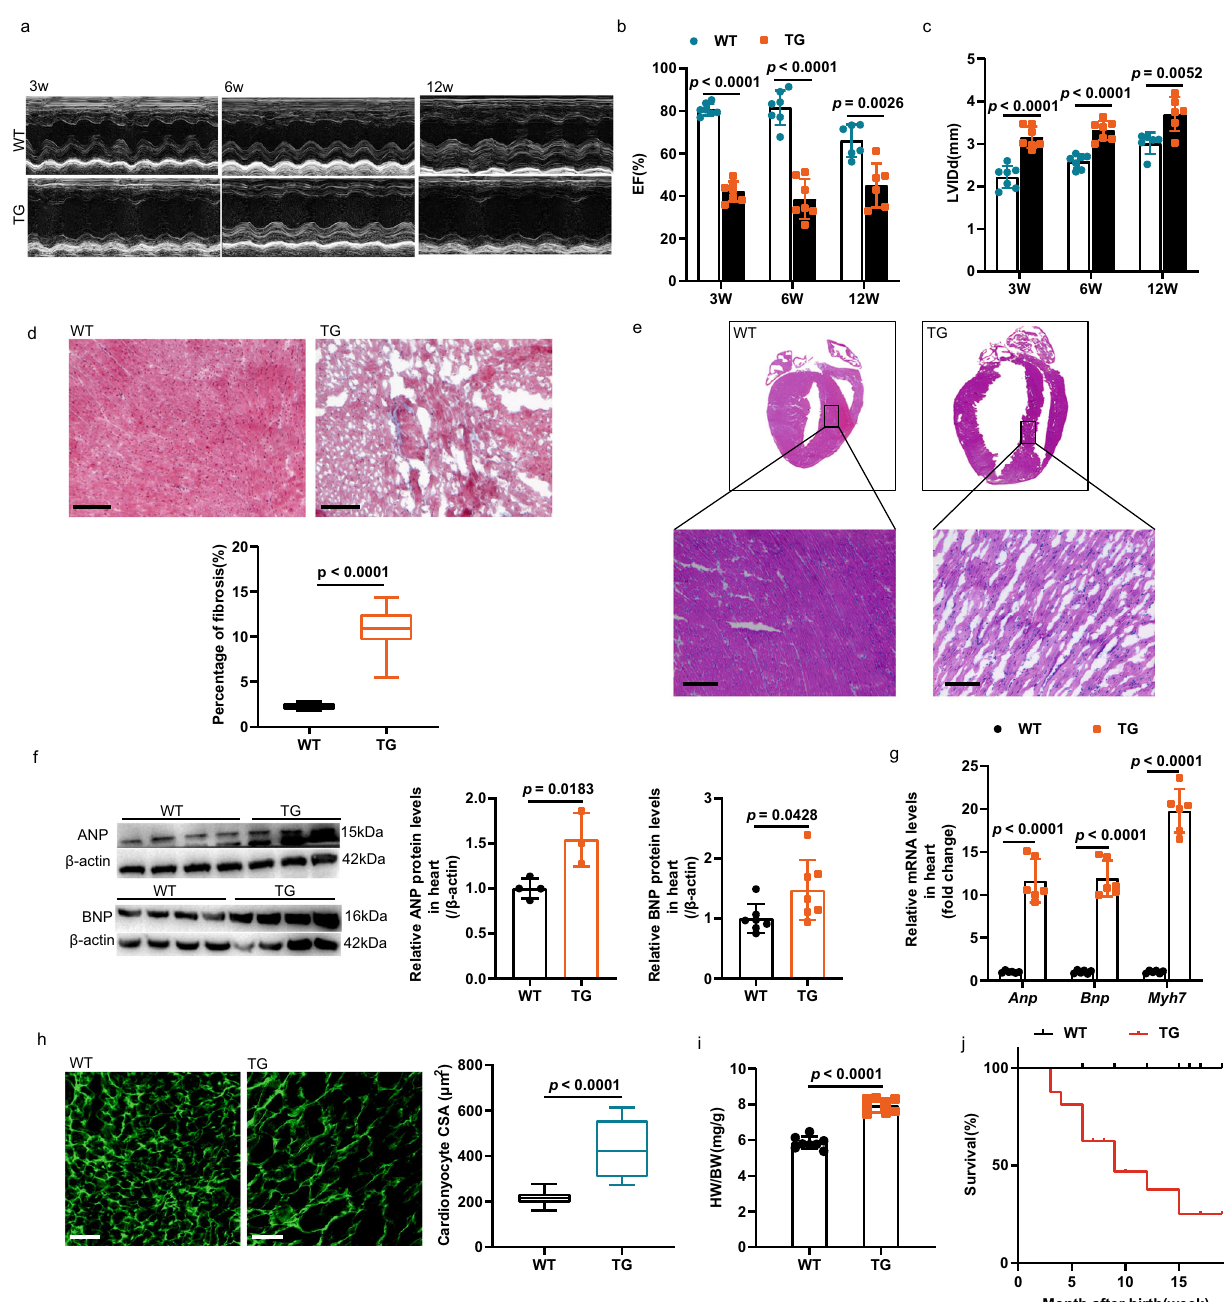
Fig. 6 | Mice with cardiomyocyte-speci fi c overexpression of Klf7 displayed cardiachypertrophyandmyocardial fi brosis.a LongaxistransthoracicM-mode echocardiographic traces from WT and TG mice at 3, 6, and 12 weeks of age. Comparison of TG mice with WT mice revealed changes in echocardiographic parameters: b a decrease in EF ( n =7 mice/group) and c anincrease in LVIDd ( n =7 mice/group). d Masson ’ s trichrome staining analysis of myocardial tissue revealed severe fi brosis, ( n =3 mice/group, 8 sections/mouse); scale bar: 500 μ m. e Disorderedmyocardialtissuearrangement( n =3mice/group,8sections/mouse), scale bar: 100 μ m. f , g Comparison of TG mice with WT mice revealed the expression of fetal genes to be upregulated ( f , ANP, WT, n =4 biologically inde- pendent samples, TG, n =3 biologically independent samples; BNP, n =7